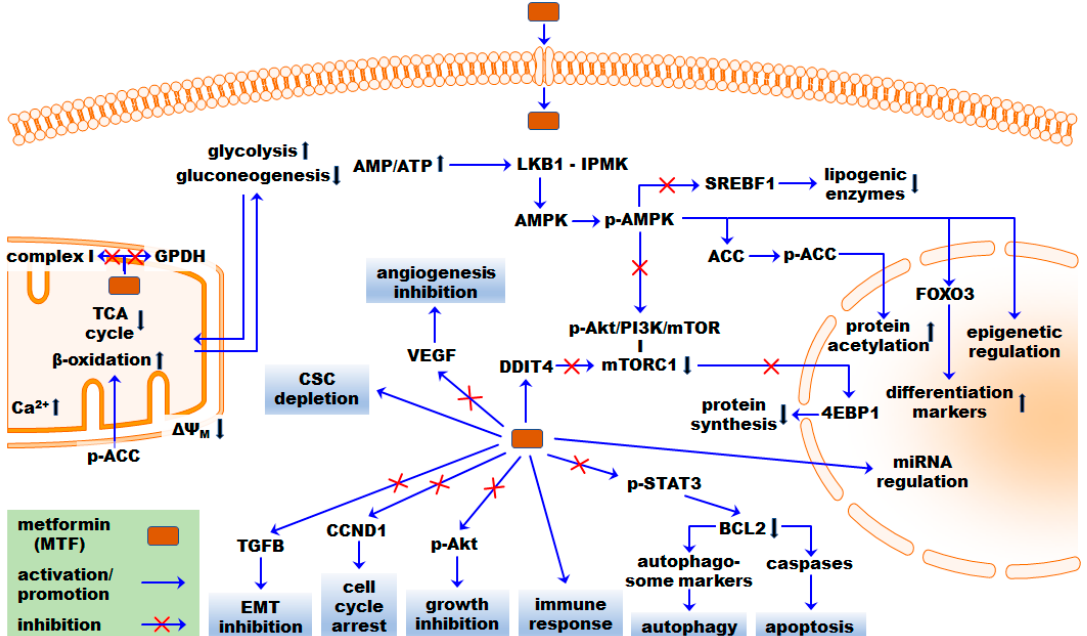
Figure 1. Putative anticancer effects of MTF exemplified by molecular and cellular key events. MTF affects key energy and metabolic processes such as the mitochondrial respiration (complex I), TCA cycle, fatty acid β -oxidation, gluconeogenesis, and glycolysis. MTF affects cellular fate processes such as cell cycle, cell growth, EMT, autophagy, and apoptosis. AMPK, the cellular key energy sensor, is phosphorylated in response to an increased AMP/ATP ratio and implicated in exerting several pleiotropic MTF effects. AMPK-dependent mechanisms include, e.g., inhibition of 4EBP1 via the Akt/PI3K/mTOR pathway. AMPK-independent mechanisms include, e.g., inhibition of mTORC1 by DDIT4. The pleiotropic effects of MTF on gene regulation include, e.g., downregulation of differentiation markers and modulation of epigenetic and mRNA features. Direct activation or inhibition processes are thoroughly known only for a limited number of molecules, such as LKB1 activation of AMPK. ∆Ψ M , mitochondrial membrane potential; 4EBP1, 4E-binding protein 1; ACC, acetyl-CoA carboxylase; Akt, AKT serine/threonine kinase 1; AMPK, AMP-activated protein kinase; BCL2, apoptosis regulator, BCL2; CCND1, cyclin D1; CSC, cancer stem cell; DDIT4, DNA damage inducible transcript 4; EMT, epithelial-to-mesenchymal transition; FOXO3, forkhead box O3; GPDH, glycerol-3-phosphate dehydrogenase; IPMK, inositol polyphosphate multikinase; LKB1, liver kinase B1; miRNA, micro RNA; mTORC1, target of rapamycin complex 1; SREBF1, sterol regulatory element binding transcription factor 1; STAT3, signal transducer and activator of transcription 3; TCA, tricarboxylic acid; TGFB1, transforming growth factor beta 1; VEGF, vascular endothelial growth factor. Phosphorylated molecules are indicated by a prefix p.